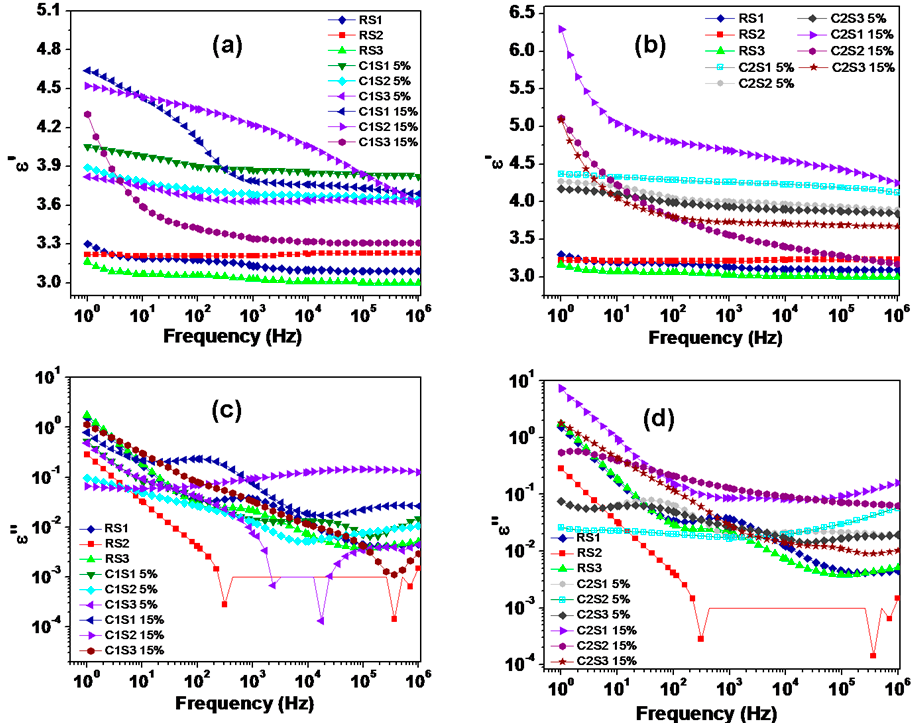
Figure 2. Dielectric properties for samples tested: ( a ) relative permittivity for composites prepared with iron complex (C1); ( b ) relative permittivity for composites prepared with chromium complex (C2); ( c ) loss factor for composites prepared with iron complex (C1); ( d ) loss factor for composites prepared with chromium complex (C2).